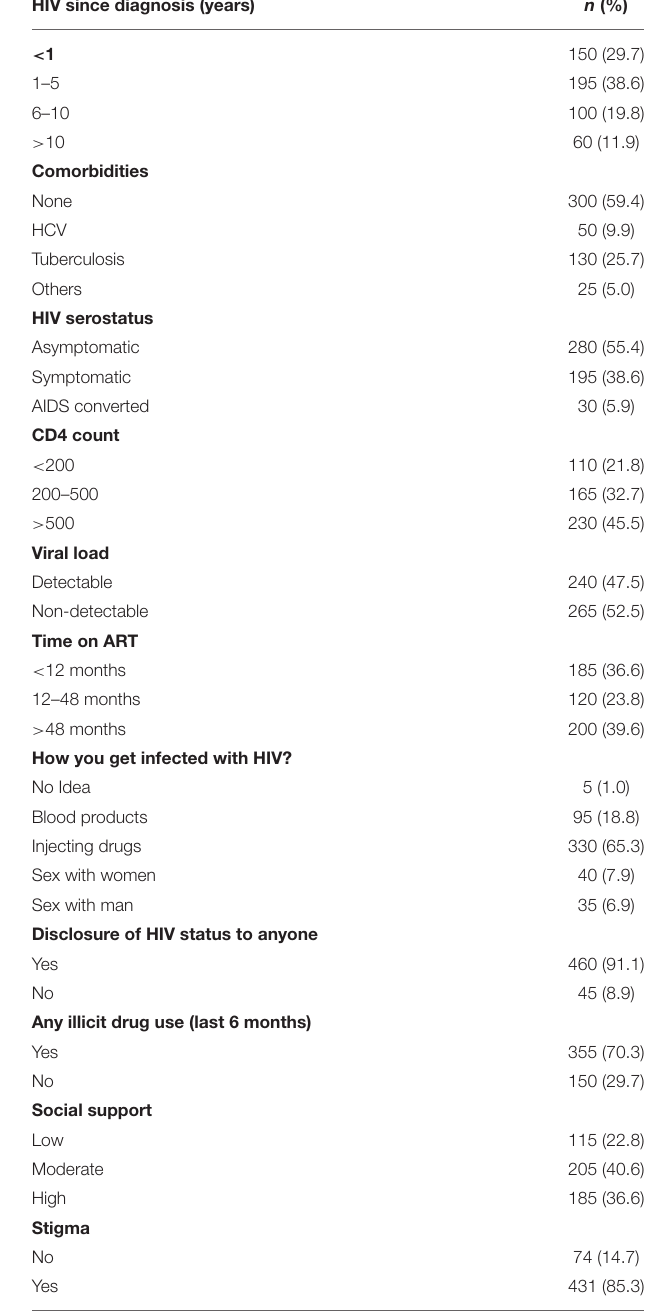
TABLE 2 | Clinical and psychological characteristics of people living with HIV/AIDS. HIV since diagnosis